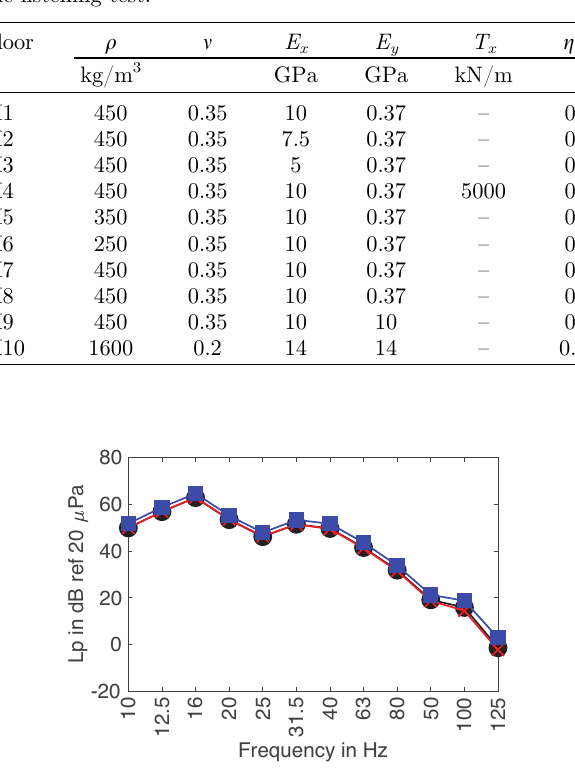
Figure 7. Simulated sound pressure levels for a light concrete fl oor (M10) for three different room con fi gurations; case 1: circles, case 2: crosses, case 3: